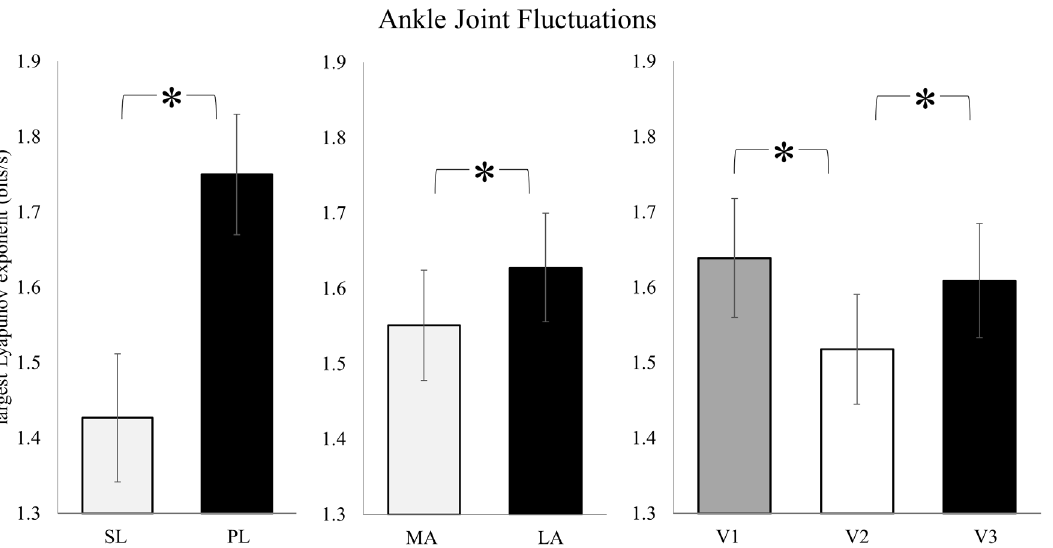
Figure 1. Stride-to-stride fluctuations for the ankle were significantly decreased for the sound leg compared to the prosthetic leg. The ‘‘more appropriate’’ prosthesis design also yielded decreased stride-to-stride fluctuations compared to the ‘‘less appropriate’’ prosthesis. Through the adaptation, a significant U-shaped quadratic trend was present, with significantly increased stride-to-stride fluctuations at the initial visit and final visit compared to the middle of the adaptation period. (mean 6 SEM) SL: sound leg; PL: prosthetic leg; MA: ‘‘more appropriate’’ prosthesis; LA: ‘‘less